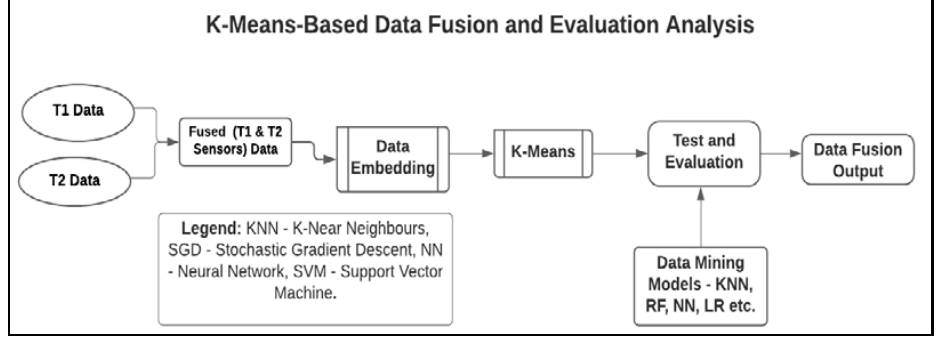
Figure 12. Simplified data fusion architecture based on the K-Means Clustering Method (KMCM).